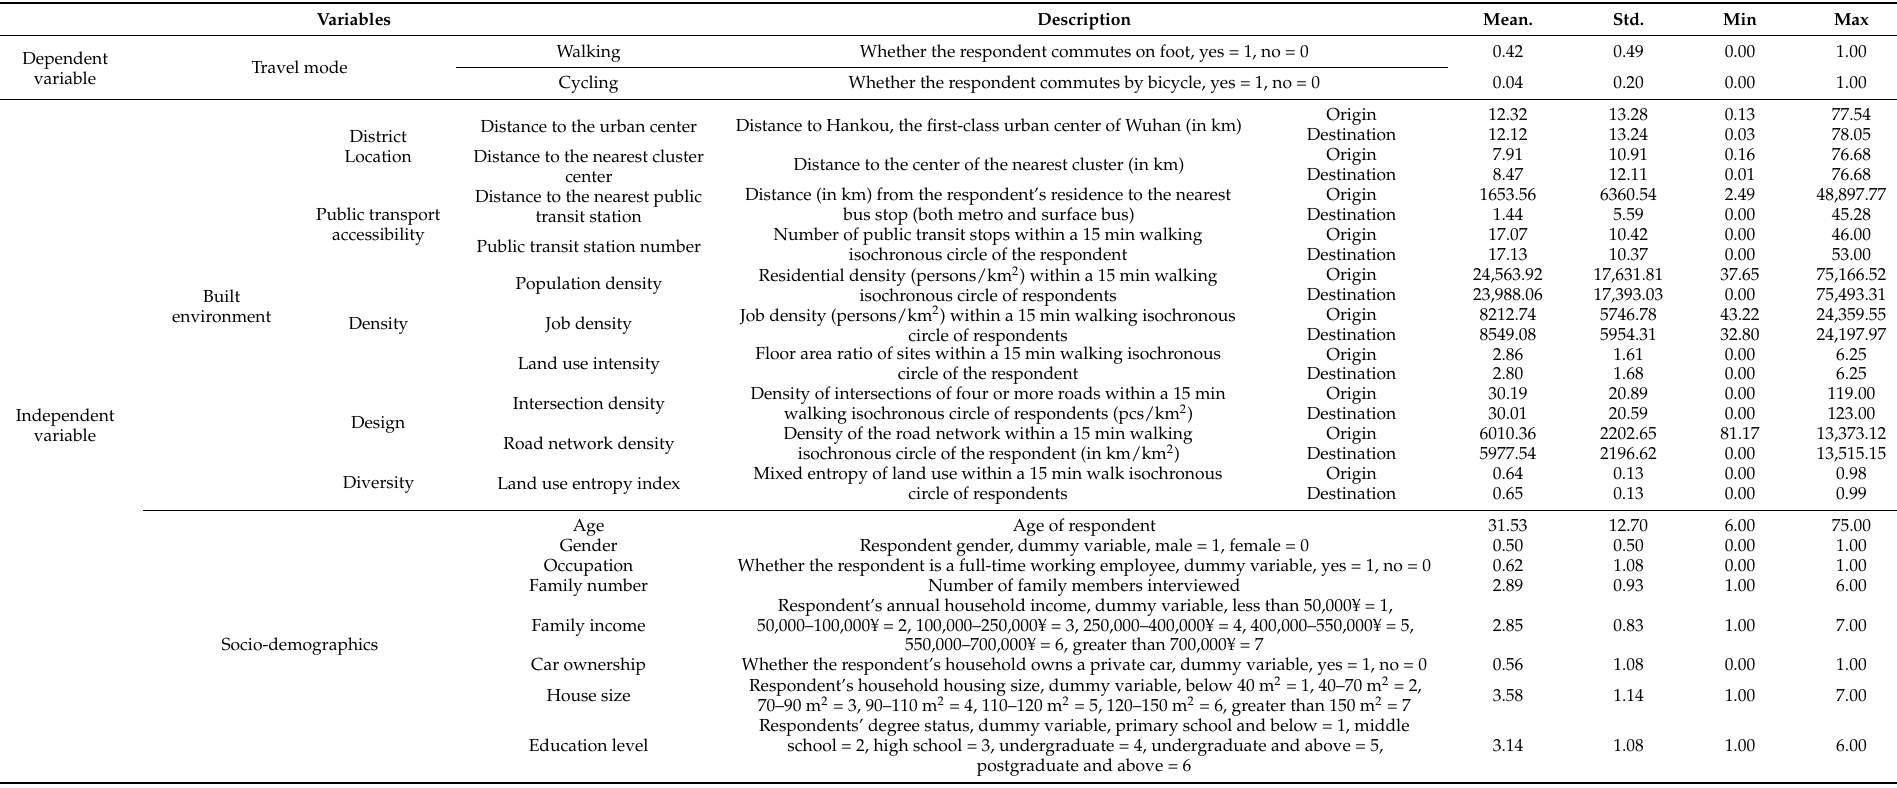
Table 4. Variable statistics